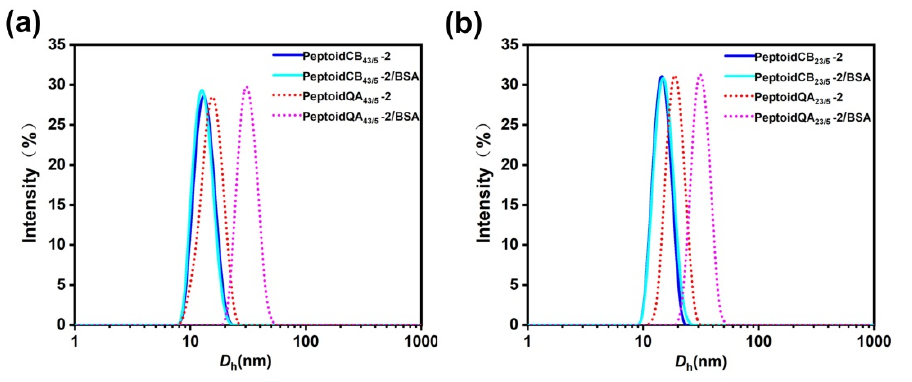
Figure 6. Interactions of BSA with ( a ) PeptoidCB 43/5 -2 / PeptoidQA 43/5 -2 and ( b ) PeptoidCB 23/5 -2/PeptoidQA 23/5 -2 by DLS.